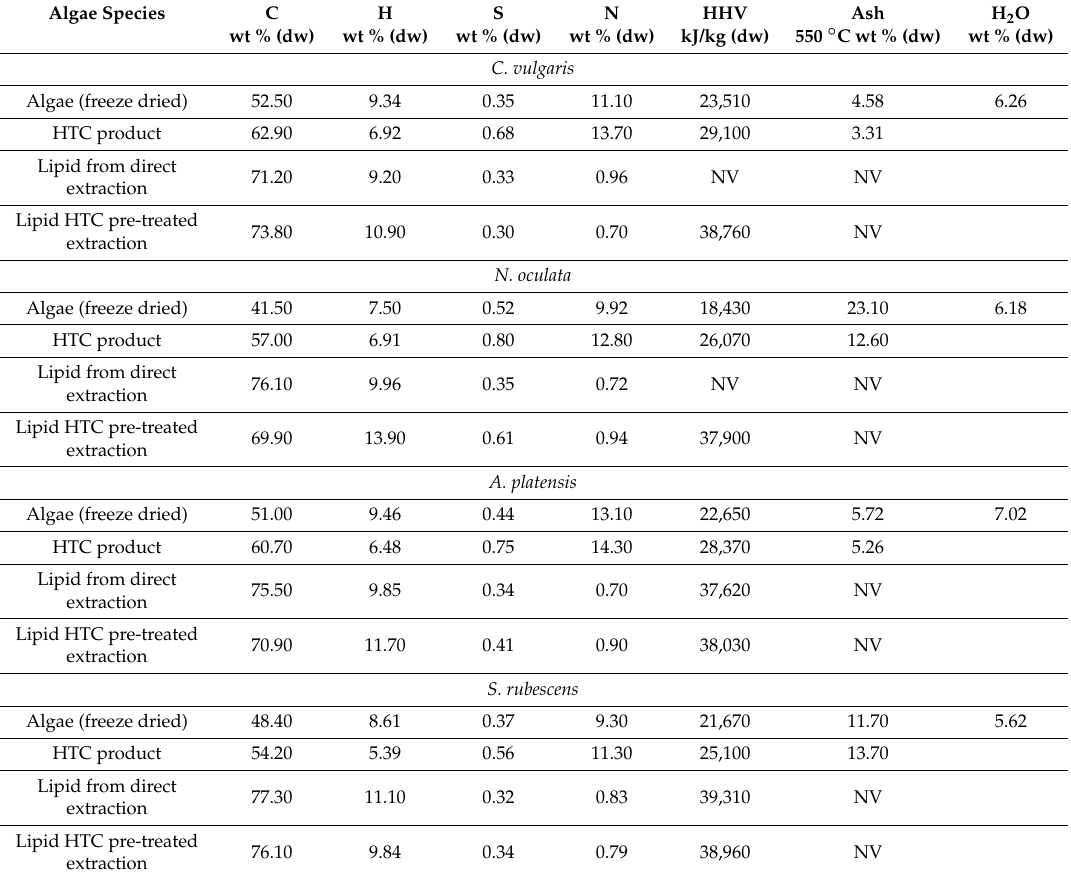
Table 1. Elemental composition of the algae species and products.